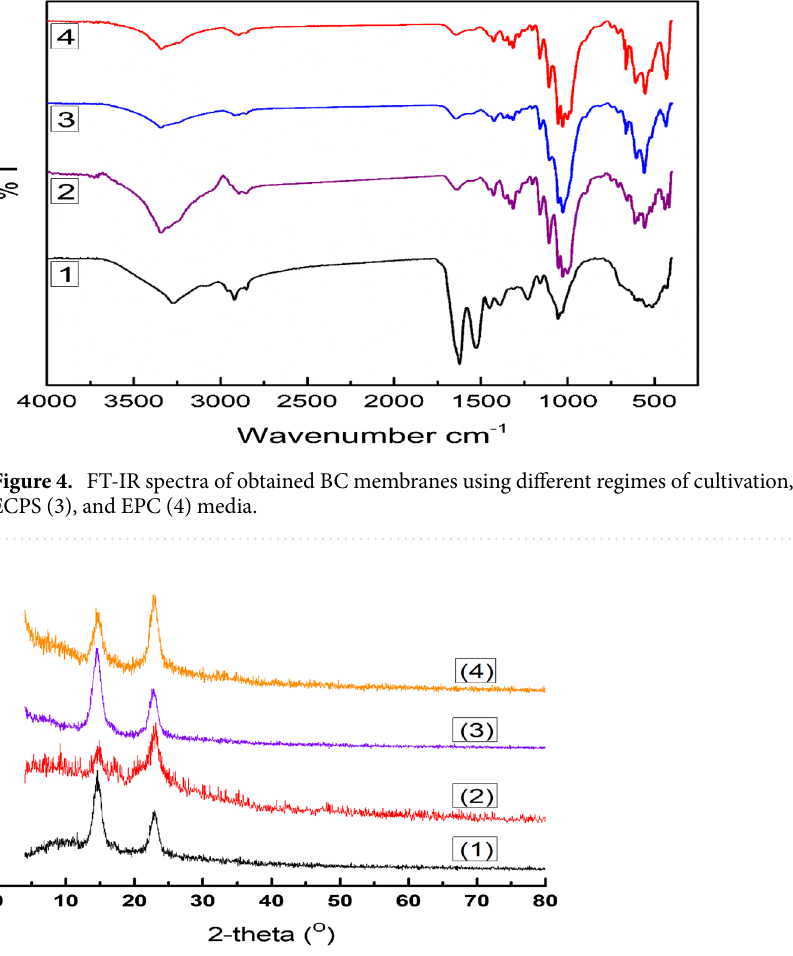
Figure 5. XRD patterns of obtained BC using different regimes of cultivation, HS (1), JCP (2), ECPS (3), and EPC (4)